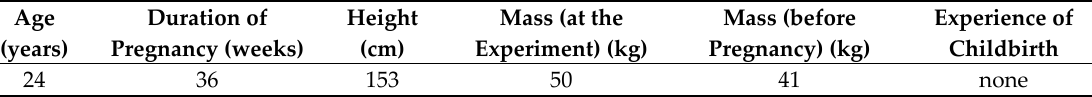
Table 1. Physical characteristics of the participant.